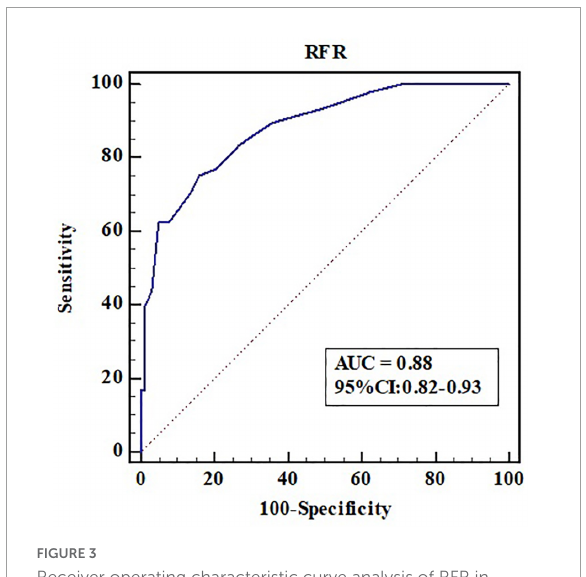
FIGURE3 Receiver operating characteristic curve analysis of RFR in predicting FFR ≤ 0.80. AUC, area under the curve; CI, confidence interval; RFR, resting full-cycle ratio; ROC, receiver operating characteristic; FFR, fractional flow reserve.